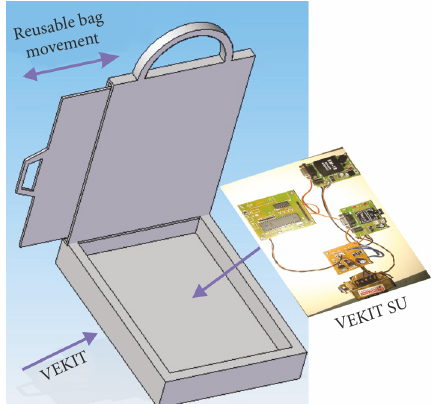
Figure 5. VEKIT prototype model case